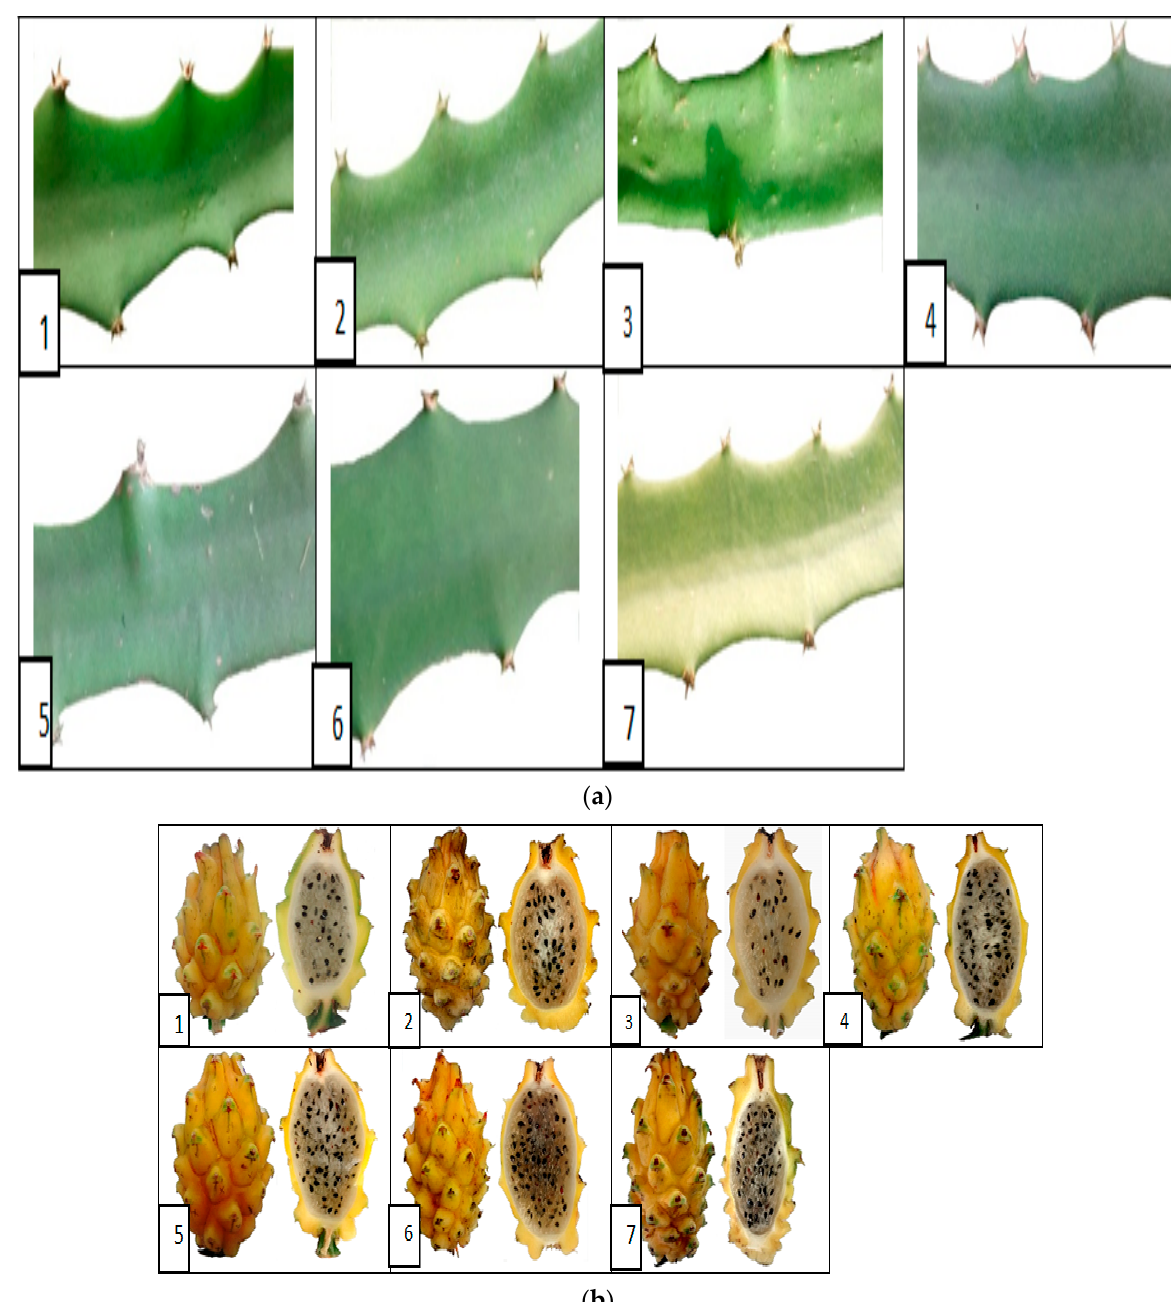
Figure 5. ( a ) Variation in width of ribs of pitahaya filocladodes characterized by farms: 1, 3, 4, 5, and 6 in the municipality of Miraflores, Russian village 2 municipality of Berbeo village Batatal; 7 municipality of Paéz, Yamuntá village. ( b ) Variation in pitahaya fruits characterized by farms: (1), (3), (4), (5), and (6) in the municipality of Miraflores vereda Rusa (2) municipality of Berbeo, Batatal district; (7) municipality of Paéz, Yamuntá village.